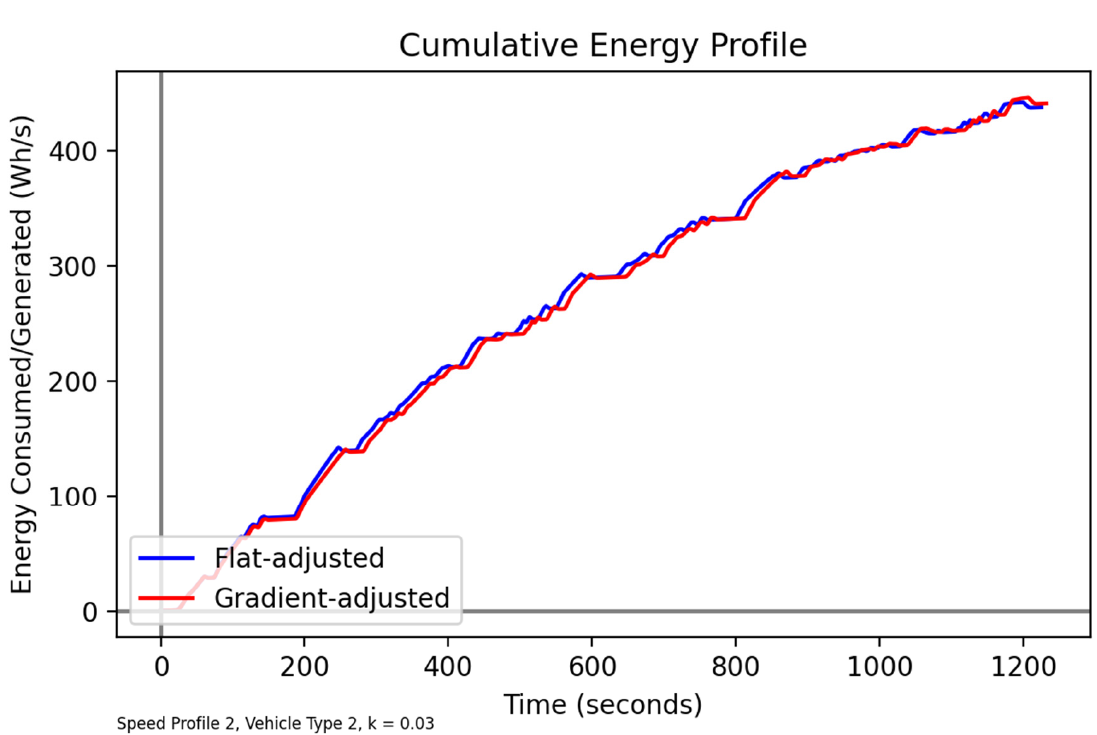
Figure 12. Comparison of cumulative energy profiles for Flat ( k = 0) vs. Gradient ( k = 0.03) adjusted speed profiles, both evaluated on k = 0.03 terrain (Both adjusted from WMTC Reference Cycle 2; Vehicle Type 2).